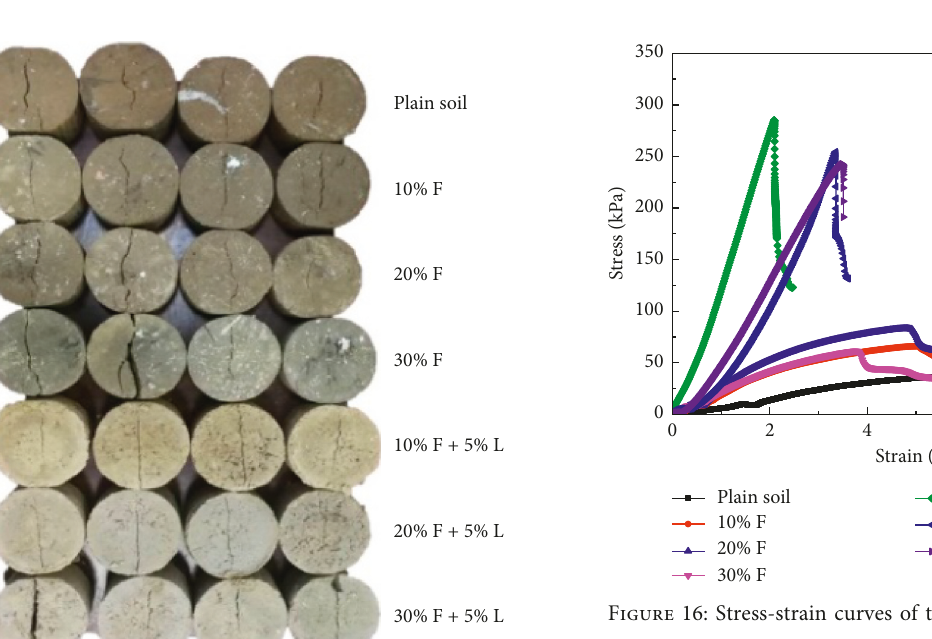
Figure 14: Schematic diagram of three typical failure mechanisms [39]: (a) tensile failure; (b) shearing failure; (c) tensile-shearing composite failure.